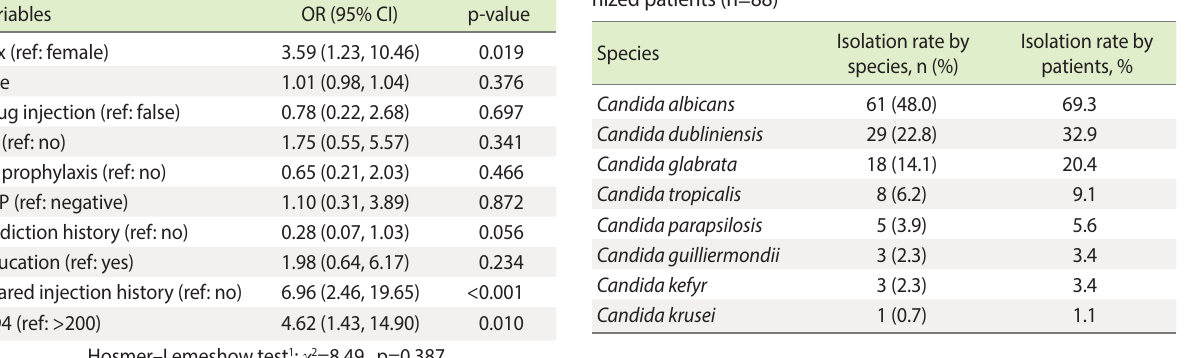
Table 5. Distribution of Candida strains (n=127) isolated from colo-